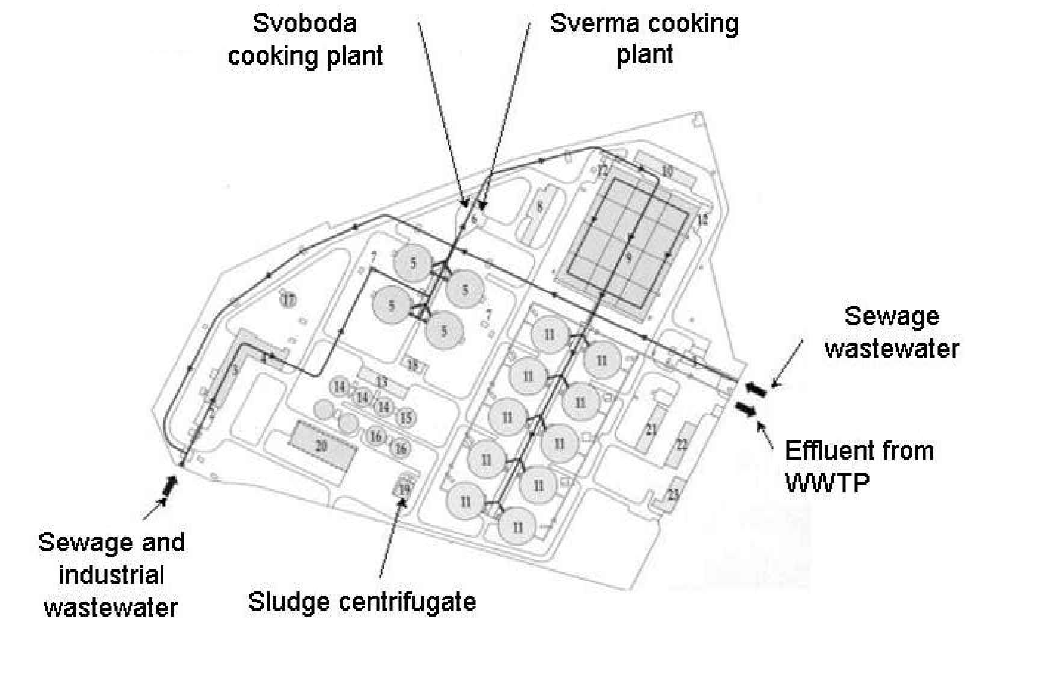
Fig. 1 Scheme of WWTP